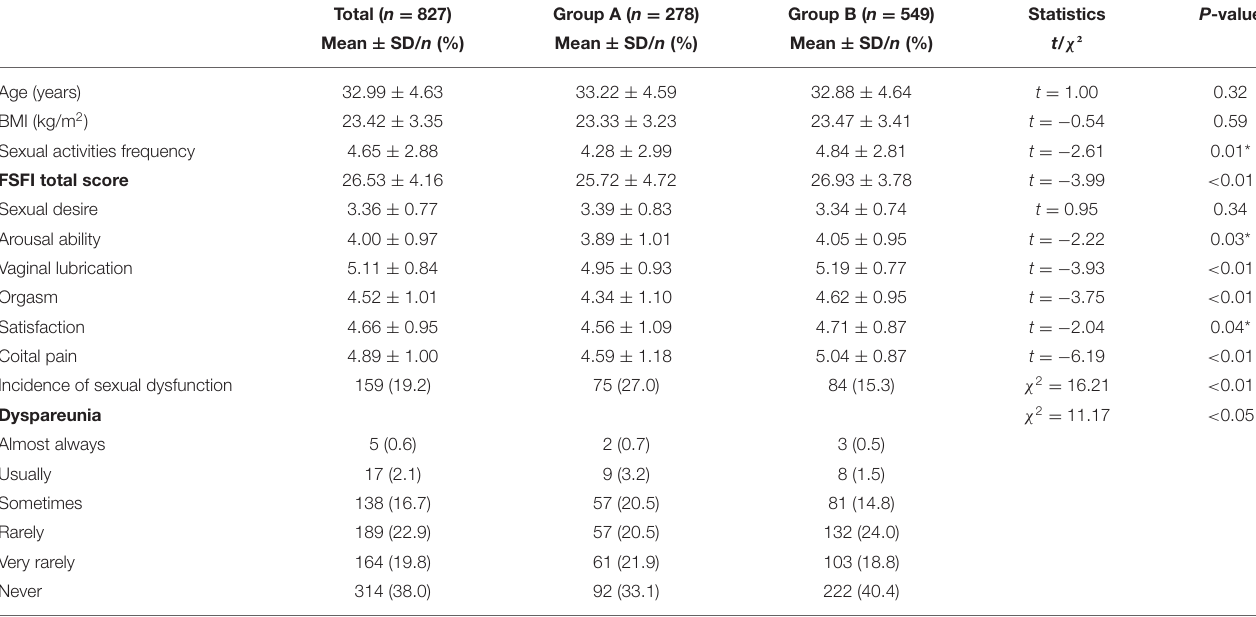
TABLE 3 | Female sexual health during COVID-19